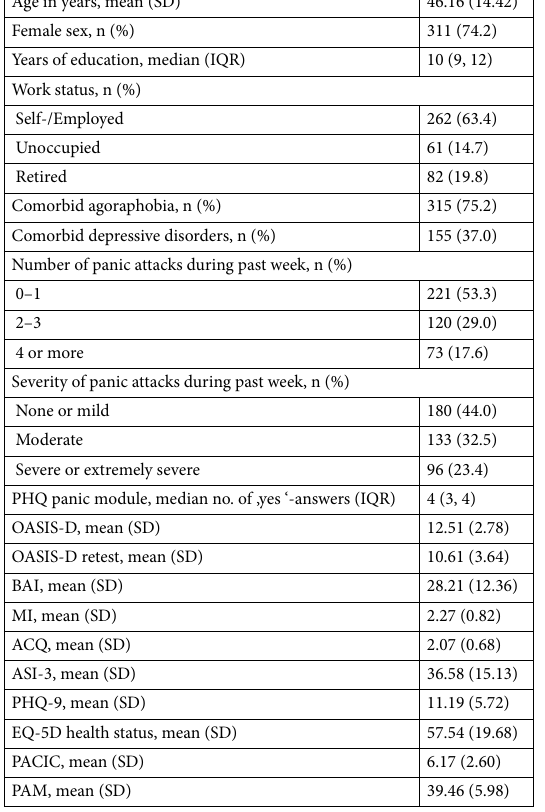
Table 1. Sociodemographic and clinical characteristics of patients with panic disorder. ACQ Anxiety Cognitions Questionnaire, ASI‑3 Anxiety Sensitivity Index-3, BAI Beck Anxiety Inventory, EQ‑5D EuroQoL questionnaire (visual analogue scale), IQR interquartile range, MI Mobility Inventory (subscale ‘alone’), OASIS‑D Overall Anxiety Severity and Impairment Scale (German version), PACIC Patient Assessment of Chronic Illness Care, PAM Patient Activation Measure, PHQ Patient Health Questionnaire, PHQ‑9 Patient Health Questionnaire (depression